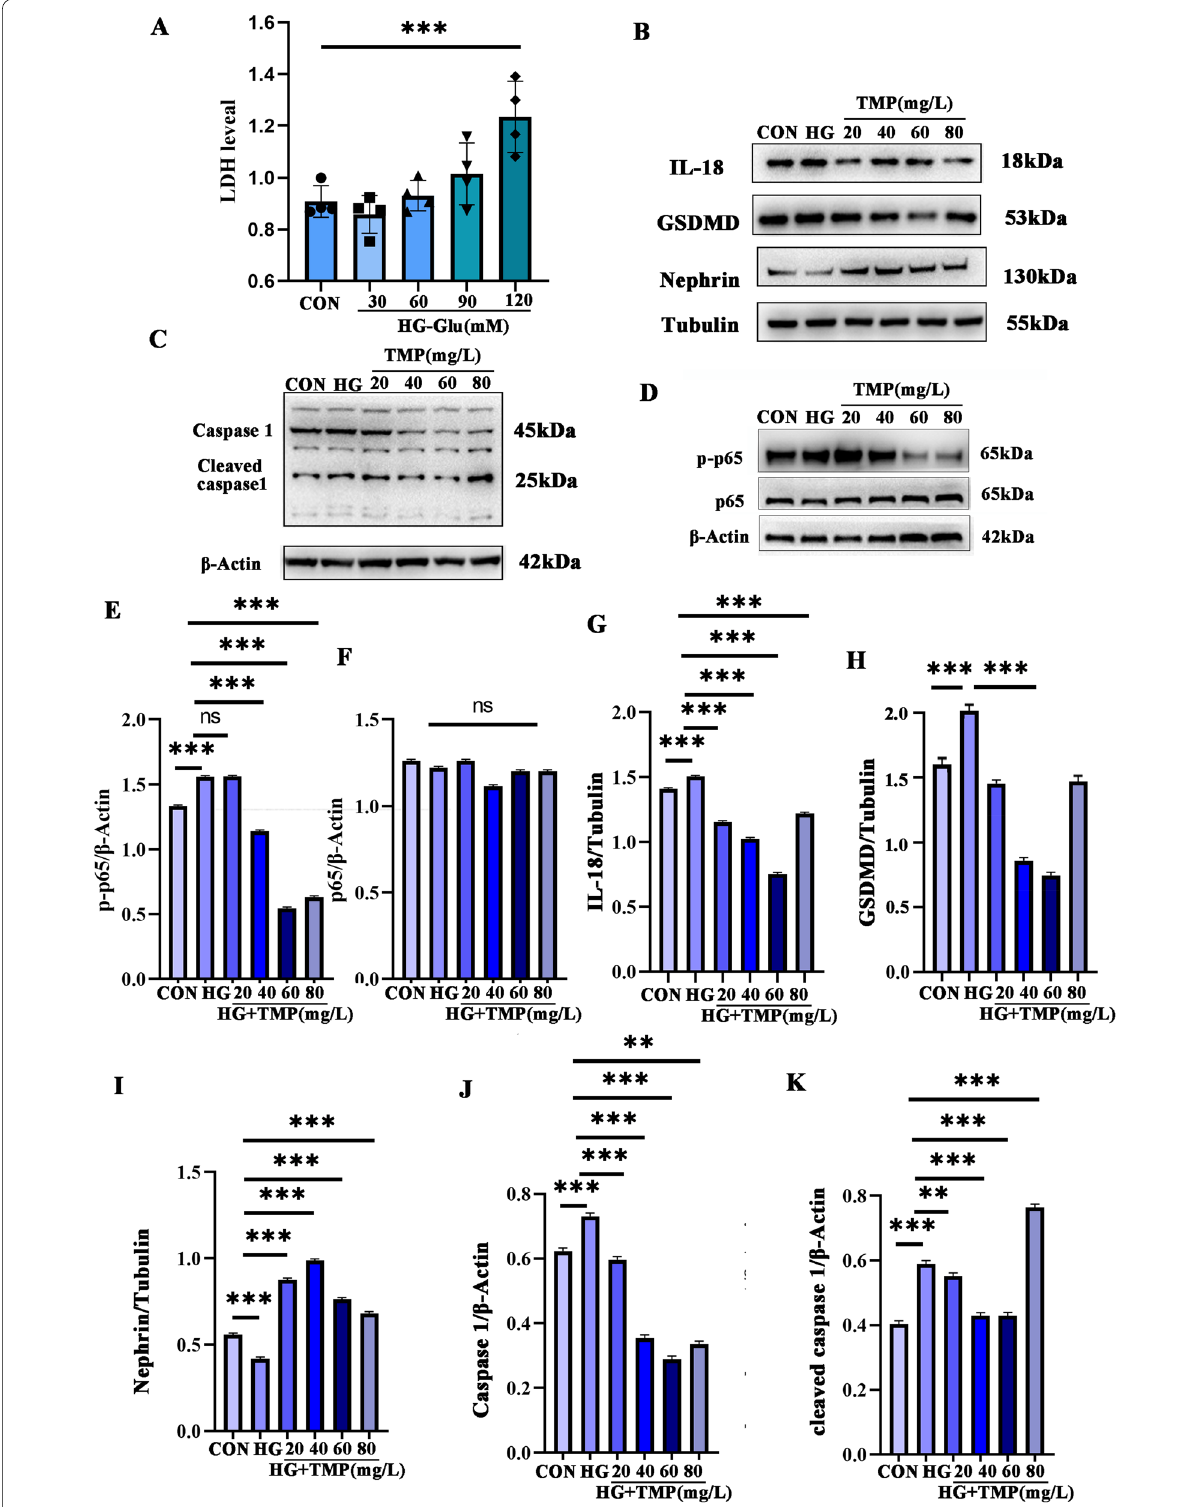
Fig. 4 A LDH releases after podocyte injury under a high glucose environment; B–D evaluation of the improvement of pyroptosis and inflammatory cellular state by the active ingredient of Chuanxiong ; E – K statistical analysis of pyroptosis and inflammation-related protein expression. * P < 0.05; ** P < 0.01; *** P <